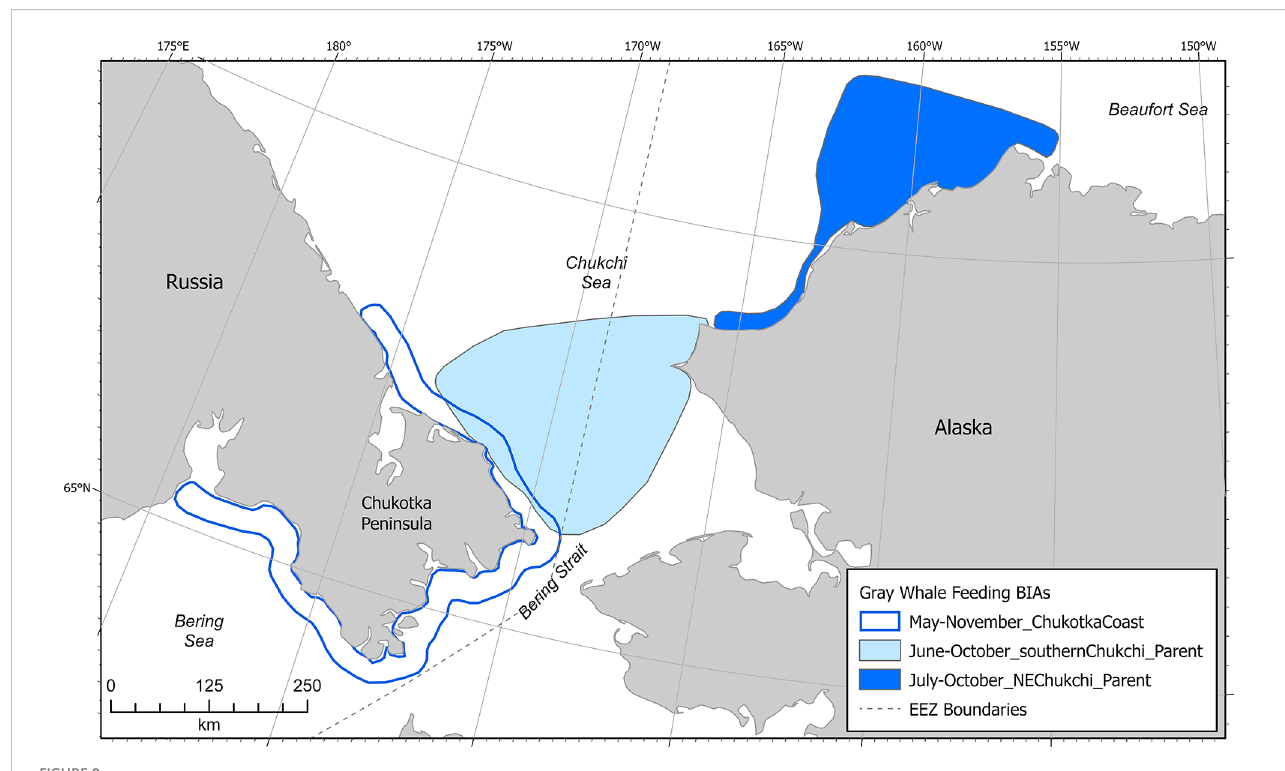
FIGURE 9 Arctic region gray whale feeding BIAs (does not include child